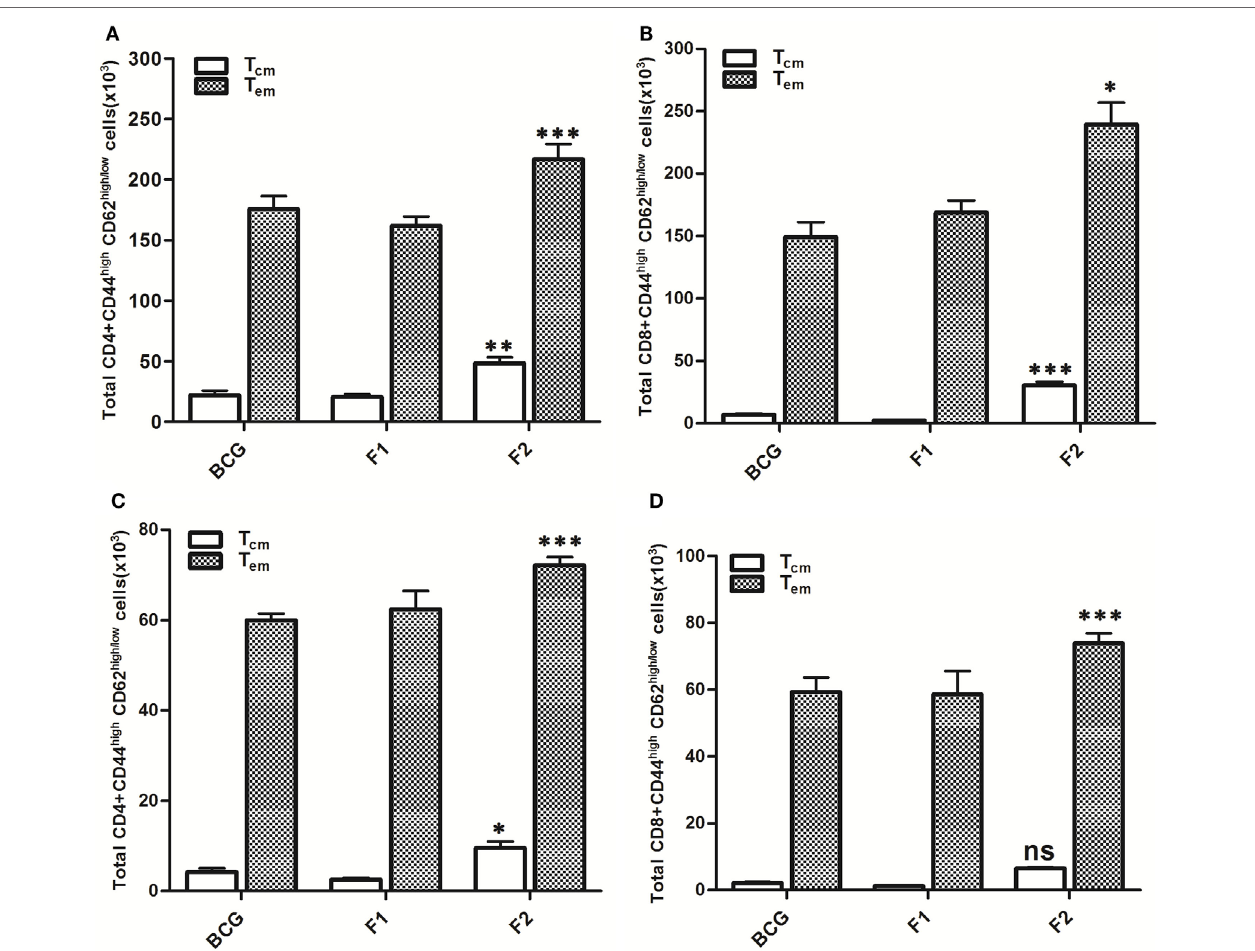
FigUre 9 | Aggregated Ag85B induces T lymphocytes with upregulated memory (effector/central) markers upto 10 weeks post challenge. After Mtb aerosol challenge, the splenocytes from various immunized groups were isolated and analyzed for the presence of CD44 high , CD62L low/high CD4 + , and CD8 + T memory cells. Graphs in figure depict the quantitave data of FACS analyzed memory markers belonging to the corresponding CD4 + and CD8 + T cells. Bar graphs in upper panel indicate the total number of CD4 + CD44 high , CD62L low/high (a) , and CD8 + CD44 high , CD62L low/high (B) T cells, respectively, in various groups at 6 weeks post challenge and the bar graphs in lower panel (c,D) reflect the quantum of same memory cells at 10 weeks post challenge time point. The data were analyzed by employing two-way ANOVA followed by Bonferroni’s multiple comparison test and are shown as the means ( ± SD) of three independent experiments. CD4 + T cells 6 weeks (a) aggregated Ag85B (F2) Vs Bacillus Calmette–Guerin (BCG): p < 0.001 CD4 + T effector memory ; p < 0.01 CD4 + T central memory Ag85B-IFA (F1) Vs BCG: p = ns CD4 +